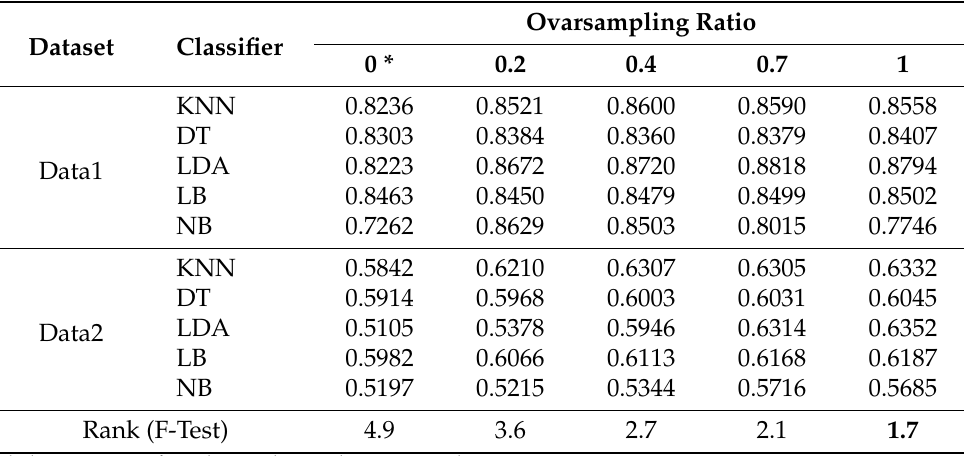
Table 6. The AUC results obtained by classification algorithms with different balancing ratios (without FS).